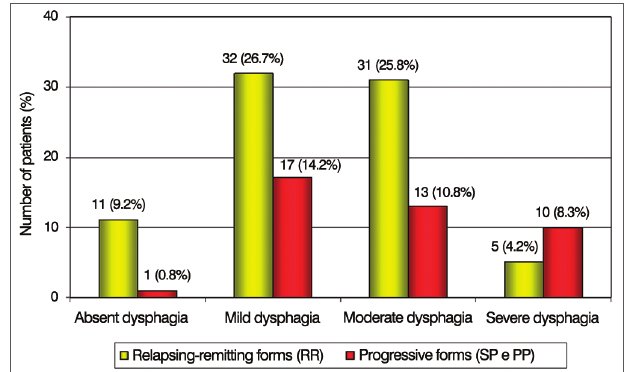
Figure 1. Patient distribution according to the severity of dysphagia and the Clinical Presentations of Multiple Sclerosis.